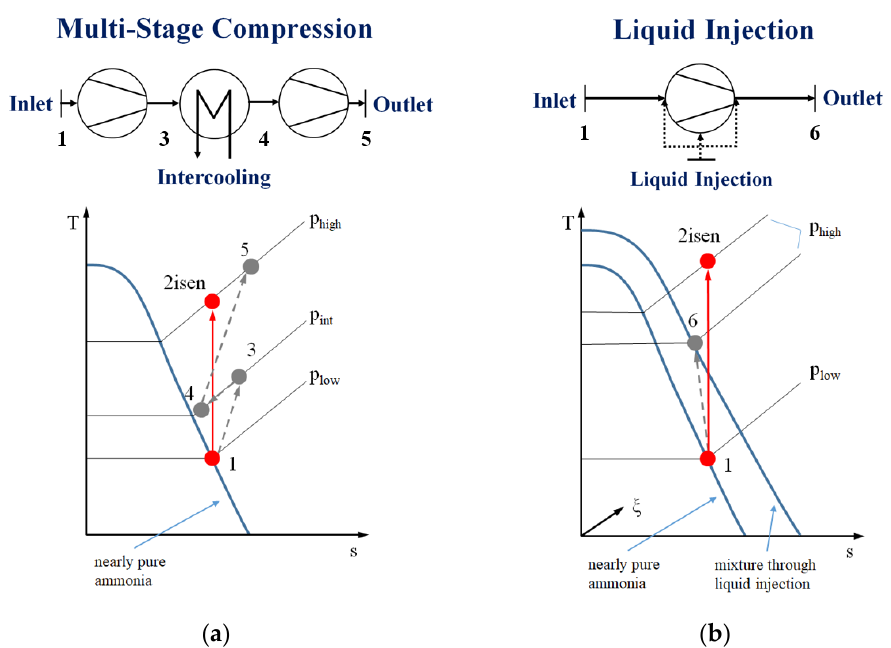
Figure 4. Different potential compressor solutions (simplified) illustrated with T-s diagrams of nearly pure ammonia including isentropic compression (solid red line) compared to: ( a ) Divided multi-stage compression with intercooling through an additional IHX and ( b ) single-stage compression with liquid injection (dashed grey lines).